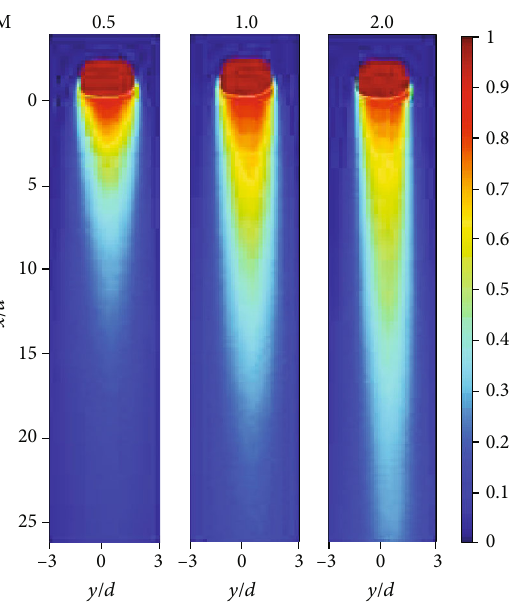
Figure 11: Experimental contours of θ = 17 : 5 °